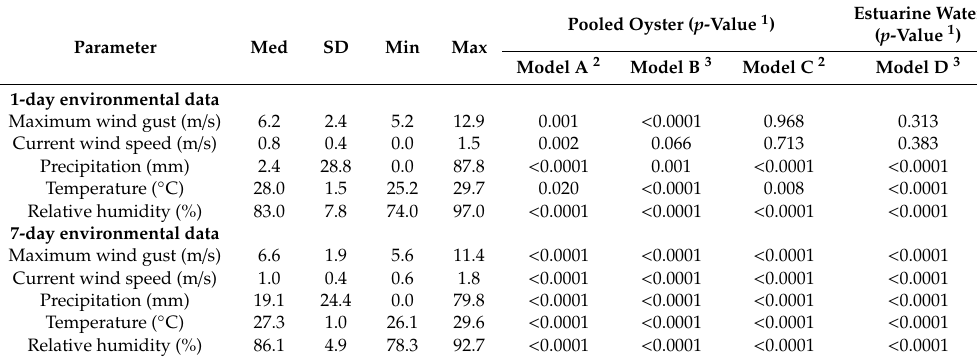
Table 1. Summary of 1-day and 7-day data for descriptive statistics on environmental parameters collected by Thai metrological department station prior to collection of oysters and estuarine waters over 12 months from March 2016 to February